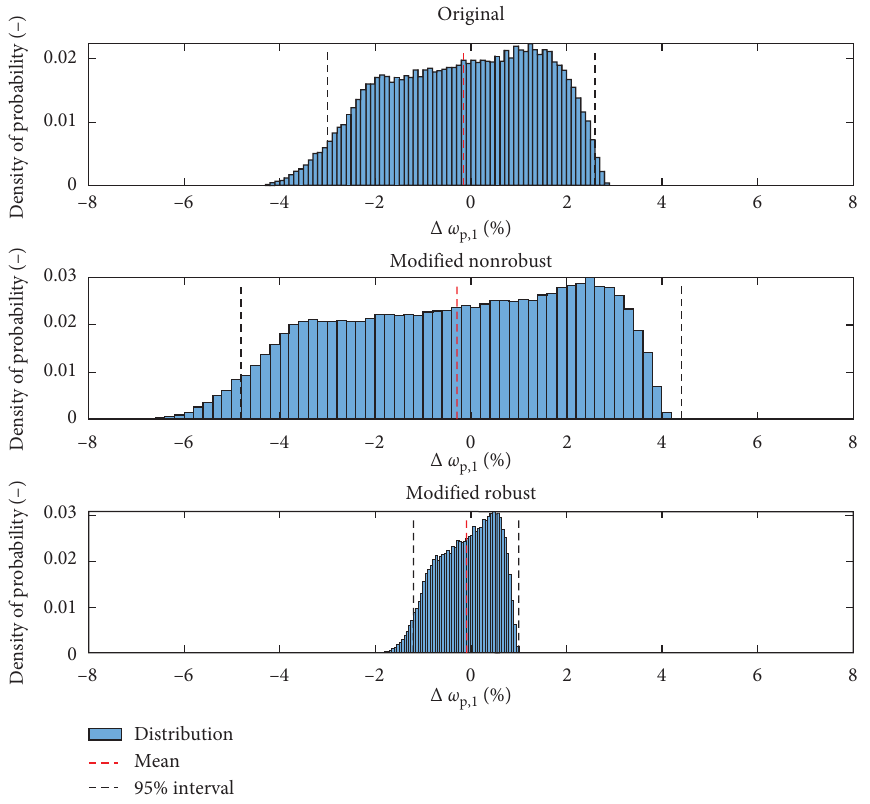
Figure 5: Test-case 1: probability density functions of Δ ω